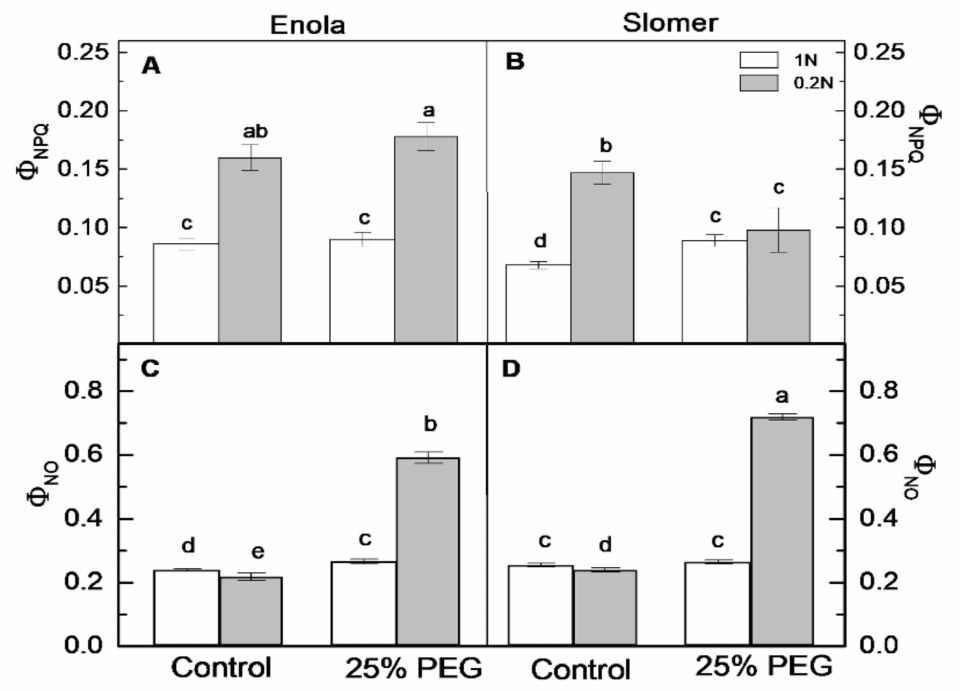
Figure 8. Non-photochemical quenching of chlorophyll fluorescence, Φ NPQ ( A , B ) and quantum efficiency of non-photochemical quenching, Φ NO ( C , D ) in leaves of two wheat varieties (Enola and Slomer) grown with two nitrogen supply levels (1 N and 0.2 N) and subjected to osmotic stress with 25% PEG. Different letters represent significant differences at p < 0.05 ( n =